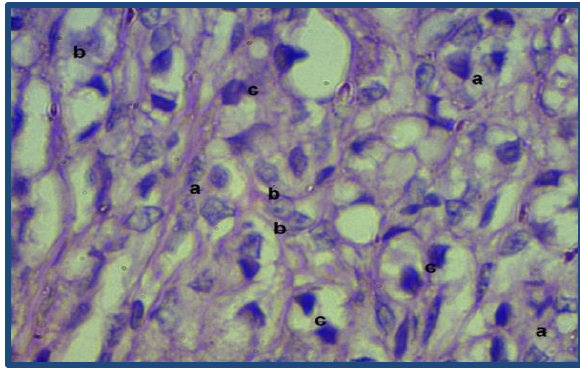
Figure, 13: Ultimobranchial gland shows: a- Groups of C-cells contain 2-3 cells with various shapes b- Light cytoplasm cells c- Dark cytoplasm cells (H and E stain, 100 X).